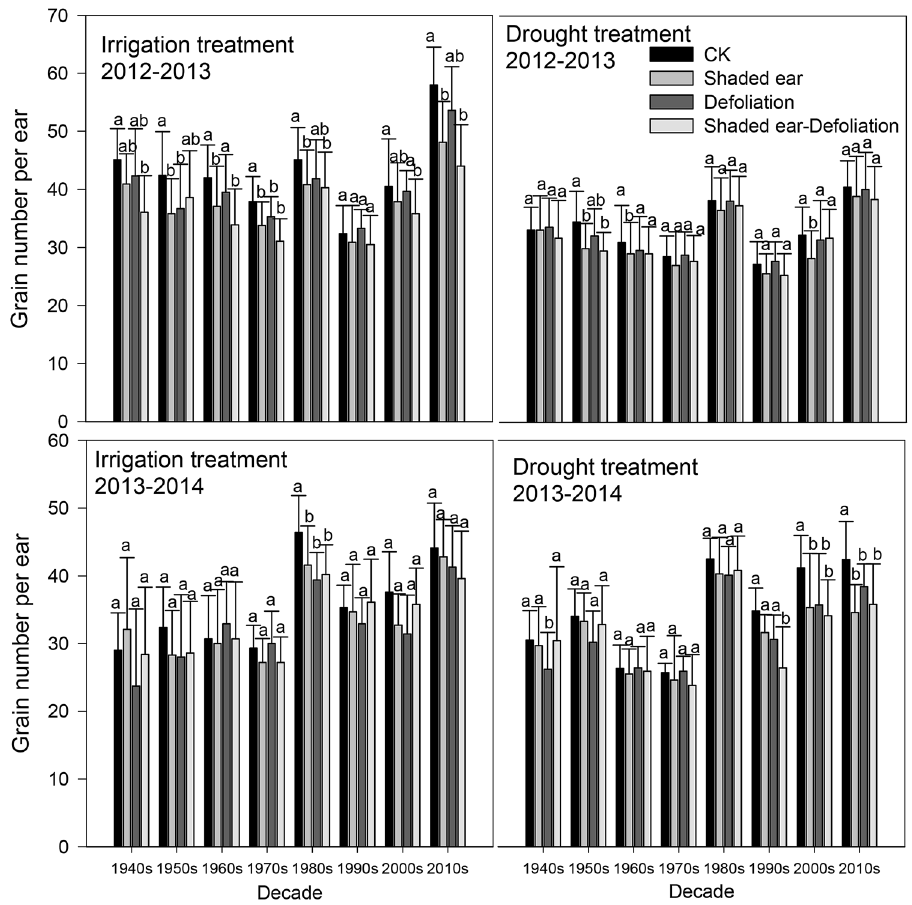
Figure 3. Shaded ear and defoliation influence on grain number per ear of different cultivars. The data represent the mean ± SE (N = 30). The different lowercase letters above the bars denote significant differences for the same cultivar under different defoliation or ear-shading treatments ( P <